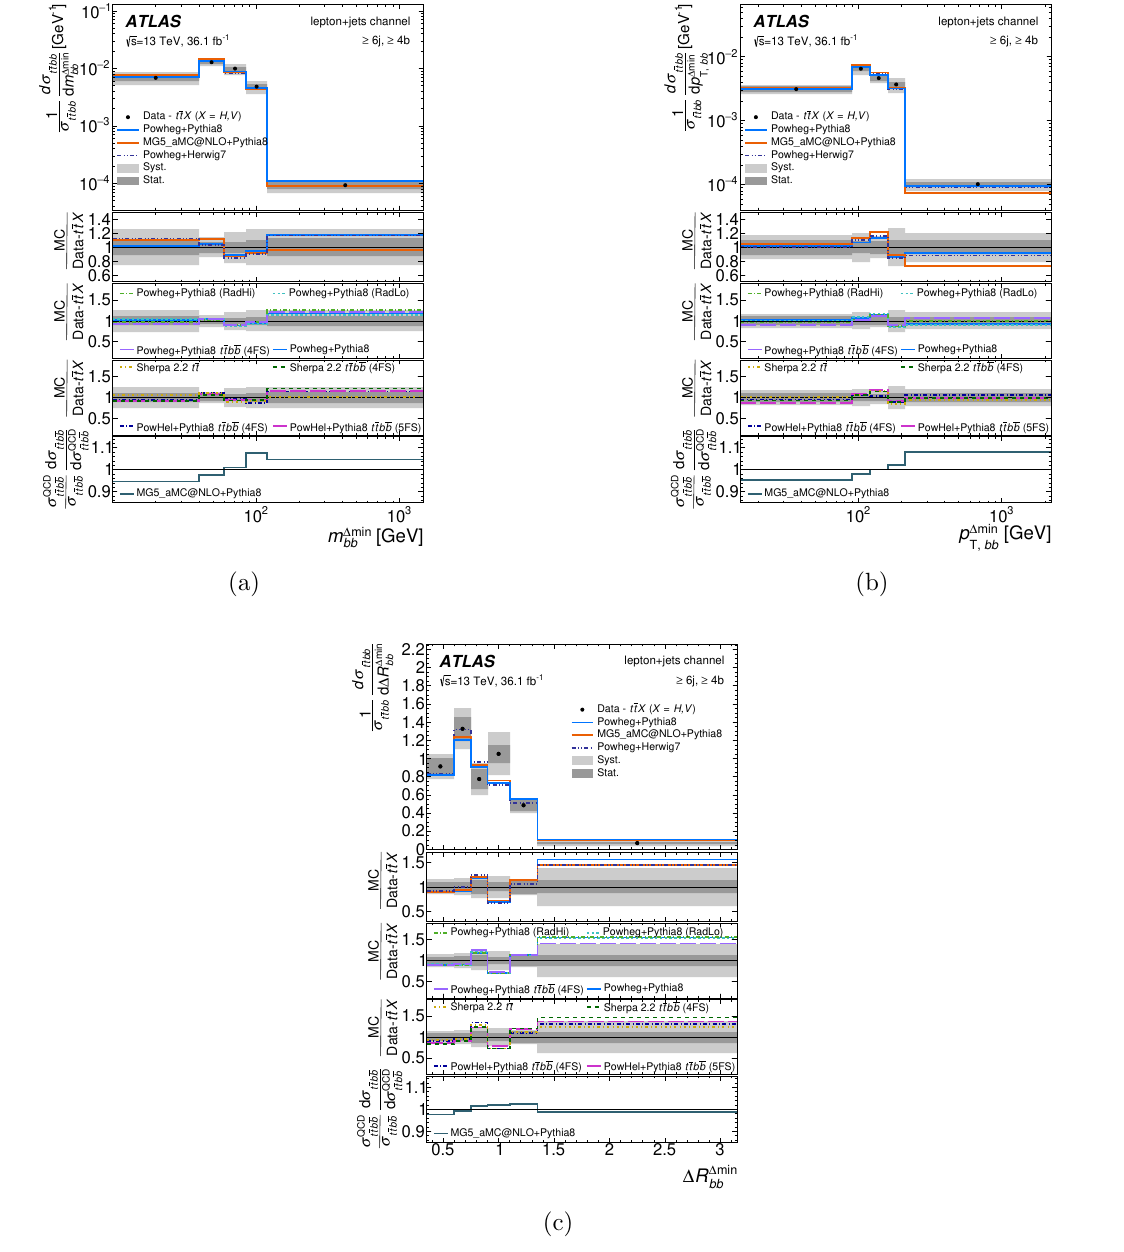
Figure 17. Relative di(cid:11)erential cross-sections as a function of (a) m (cid:1)min (cid:1) R (cid:1)min of two closest b -jets in (cid:1) R in events with at least four b -jets in the lepton + jets chan- bb nel compared with various MC generators. The t (cid:22) tH and t (cid:22) tV contributions are subtracted from data. Four ratio panels are shown: the (cid:12)rst three show the ratios of various predictions to data. The last panel shows the ratio of predictions of normalised di(cid:11)erential cross-sections from Mad- Graph5 aMC@NLO+ Pythia 8 including (numerator) and not including (denominator) the con- tributions from t (cid:22) tV and t (cid:22) tH production. Uncertainty bands represent the statistical and total systematic uncertainties as described in section 8. Events with observable values outside the axis range are not included in the